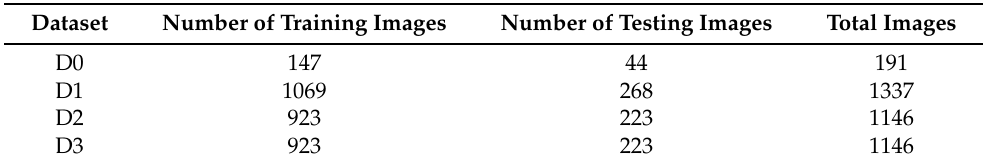
Table 4. Number of training and testing images in Datasets D0–D3. The last column shows the total number of images of each